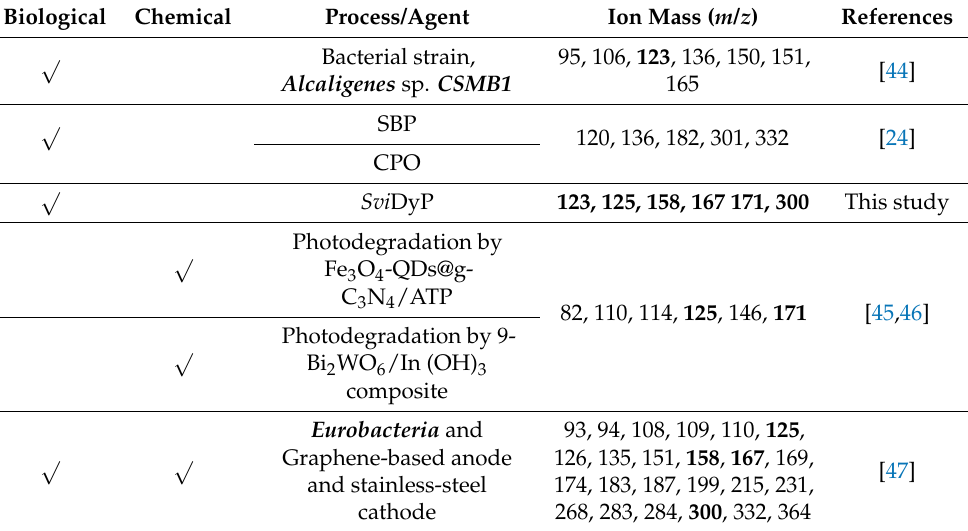
Table 5. Previously and currently reported intermediates of MBT generated during biological and chemical